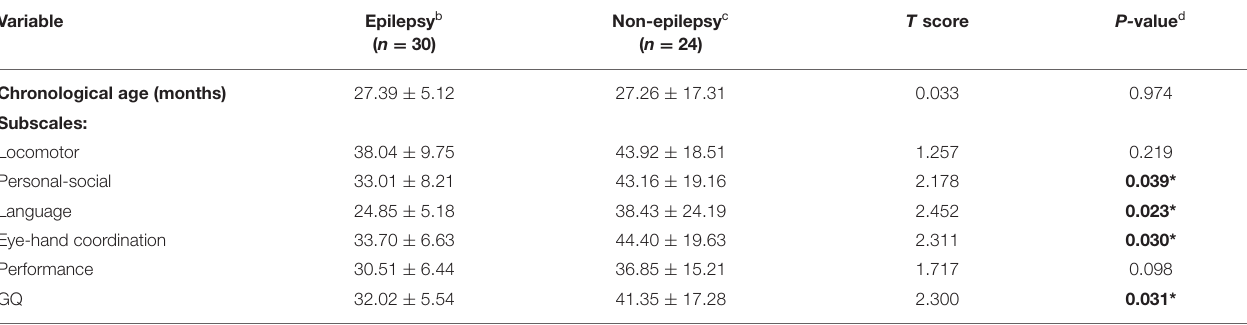
TABLE 4 | Correlation between neurodevelopment and epilepsy a .